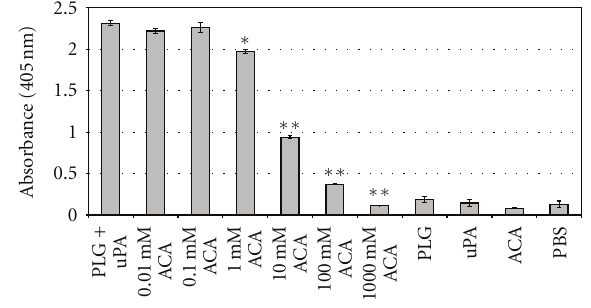
Figure 3: Inhibition of PLG binding to L. interrogans by ACA. Low-passage virulent L. interrogans serovar Copenhageni cells were treated with the following: PLG together with uPA (PLG + uPA), PLG together with uPA with the addition of crescent concentrations of ACA (0.01 to 1,000 mM ACA), PLG alone (PLG), uPA alone (uPA), ACA alone (ACA), and no additions (PBS). The cleavage of the plasmin-specific substrate D-Val-Leu-Lys 4-nitroanilide dihydrochloridein by the treated spirochetes was measured by absorbance readings at 405 nm. Bars represent mean absorbance ± the standard deviation of three replicates for each experimental group and are representative of three independent experiments. Statistically significant substrate degradation inhibition results in comparison to the positive control (PLG + uPA) are shown: P < 0.01 ( ∗ ) and P < 0.0001 ( ∗∗